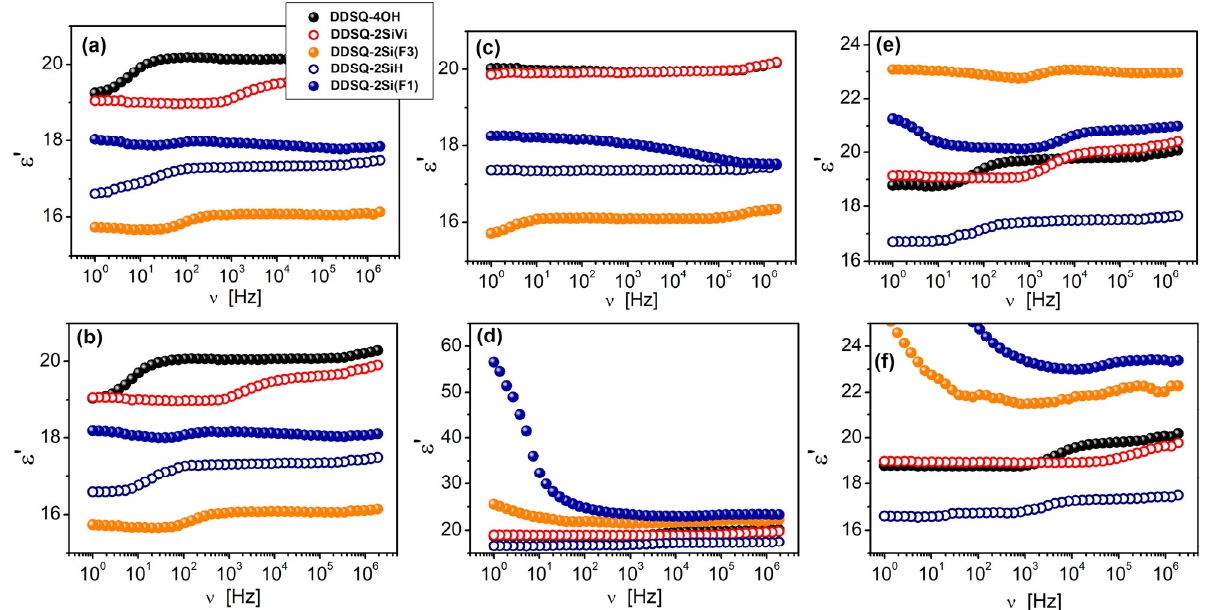
Figure 7. Frequency dependence of dielectric permittivity measured for respective compounds: DDSQ-4OH , DDSQ-2SiVi , DDSQ2Si(F3) , DDSQ-2SiH , DDSQ-2Si(F1) at different temperatures: ( a ) 20 °C (pristine sample, before thermal studies), ( b ) 20 °C (after 300 min, at T = 20 °C), ( c ) − 100 °C (minimum temperature), ( d ) 100 °C (maximum temperature) and ( e ) 20 °C (after thermal treatment). Plot ( f ) shows parts of the data collected at T = 100 °C.